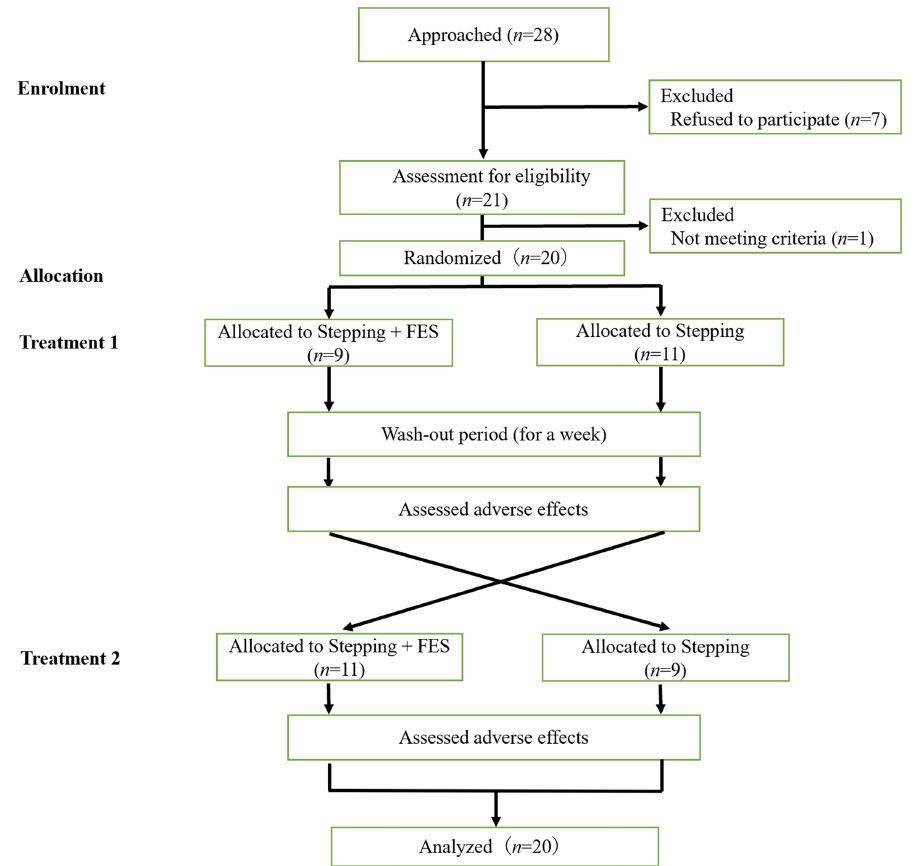
Figure 1. Chart of the recruitment and randomization procedures. Table 1. Characteristics of subjects.